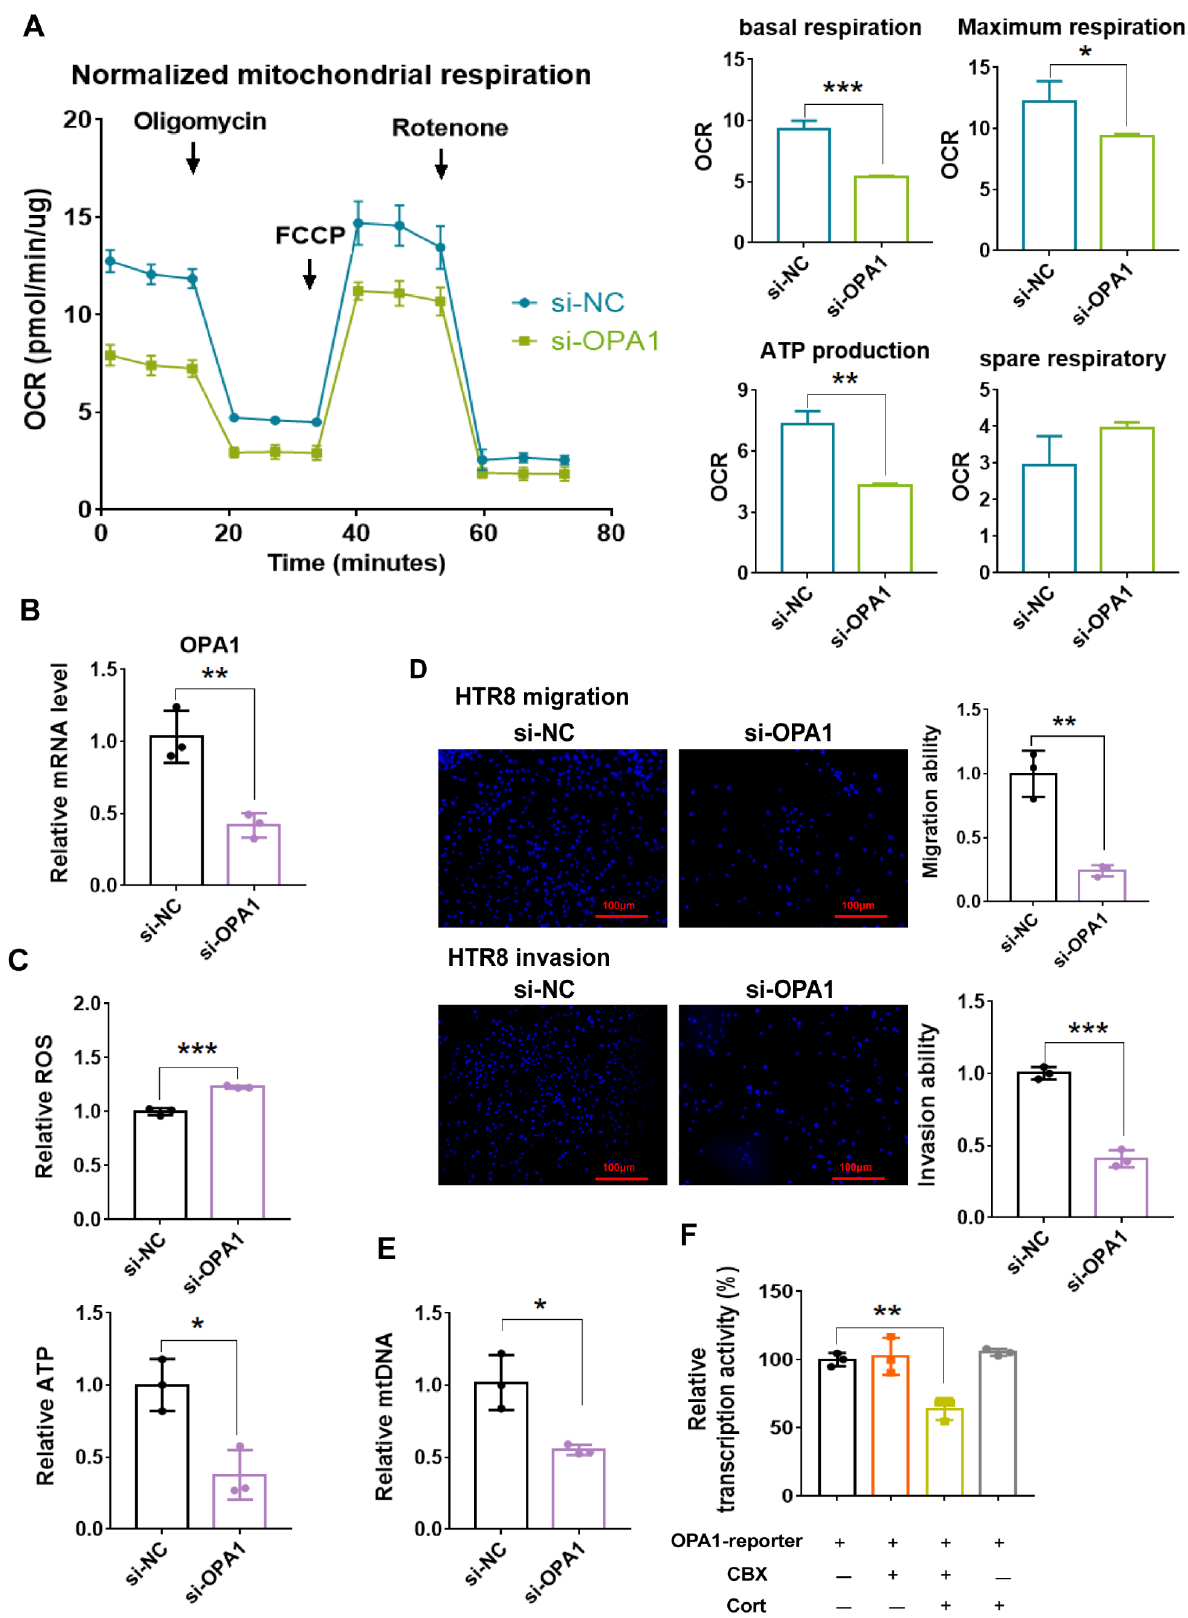
Figure 7. OPA1 downregulation leads to mitochondrial dysfunction and impaired migration and invasion function in EVTs and OPA1 transcription is regulated by 11 β -HSD2 in EVTs. HTR8 cells